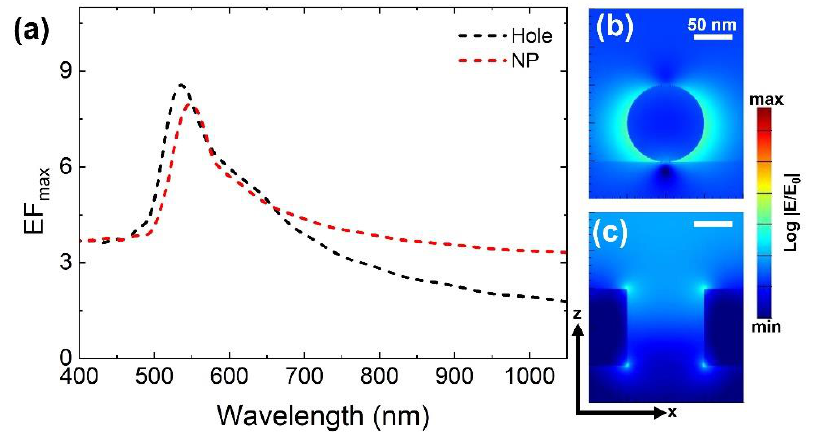
Figure 2. ( a ) Near-field enhancement EF max spectral properties taken from individual NP and metallic hole on SiO 2 substrate. Extracted cross-sectional XZ electric field profiles from their resonance wavelength position of NP structure ( b ) and metallic hole structure ( c ) at 550 nm and 535 nm, respectively. Scale bars in Figure 2b,c correspond to 50 nm.